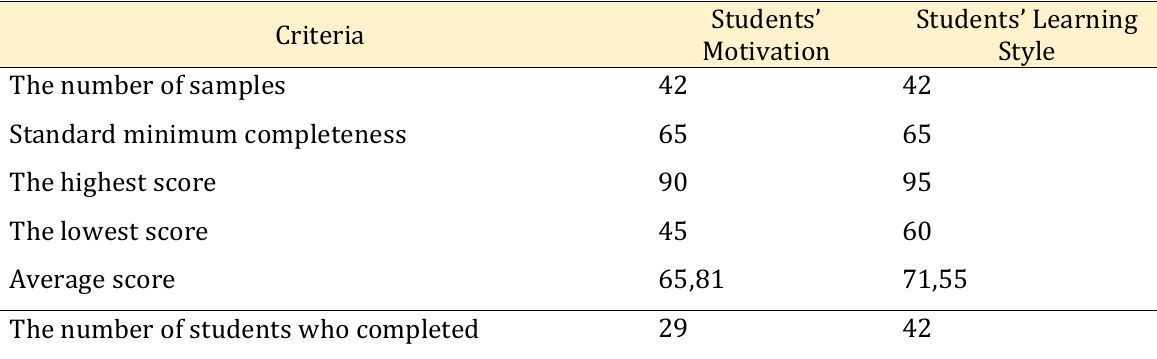
Table 3. The Students’ Learning Motivations and Learning